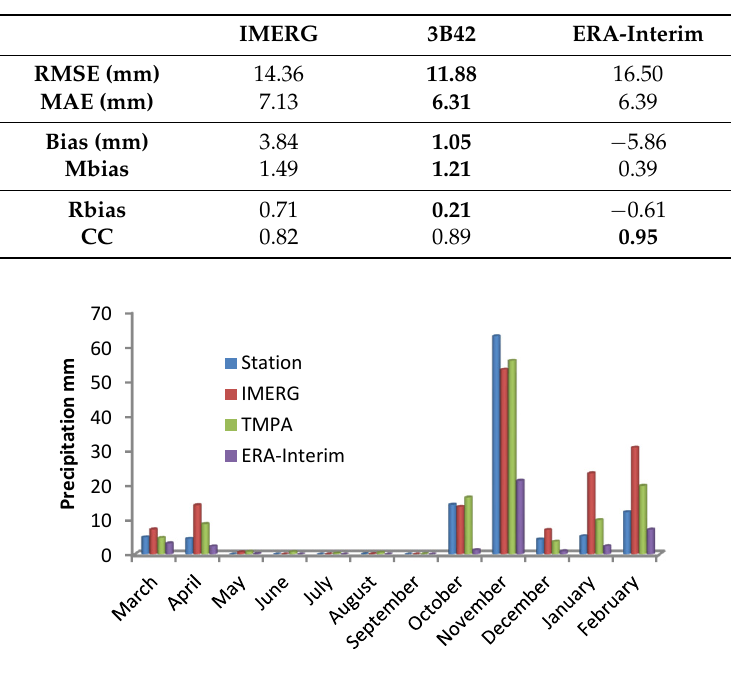
Figure 9. Bushehr monthly precipitation (mid-March 2014 to February 2015). Table 10. Statistical indices of monthly precipitation in Kermanshah area (mid-March 2014 to February 2015).